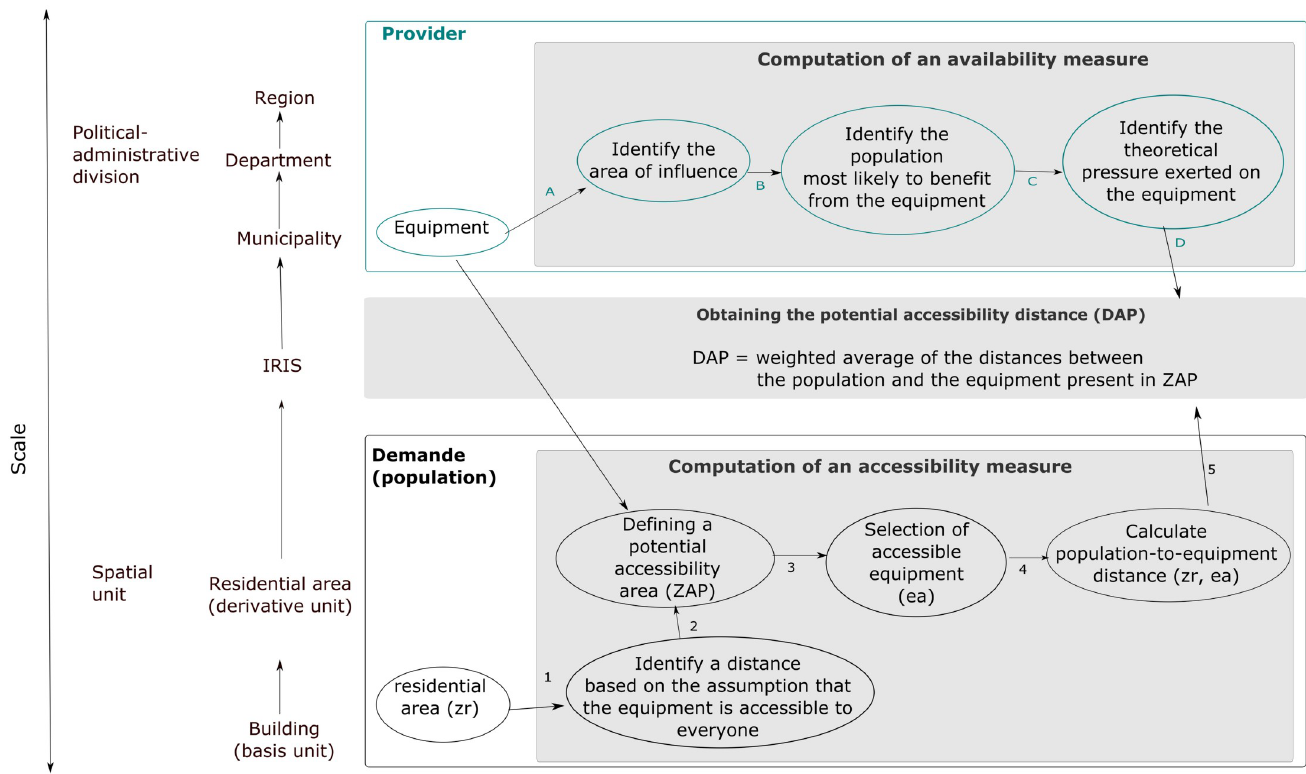
Fig 1. Construction of value per category. ( � ) average population—median population for each scale: region = 2 852 965–2 132 882; department = 653 804–534 139; municipality = 1 714–428; IRIS = 1 250–727, 2 372–2 347 using only IRIS different from municipality; residential area = 23–1.